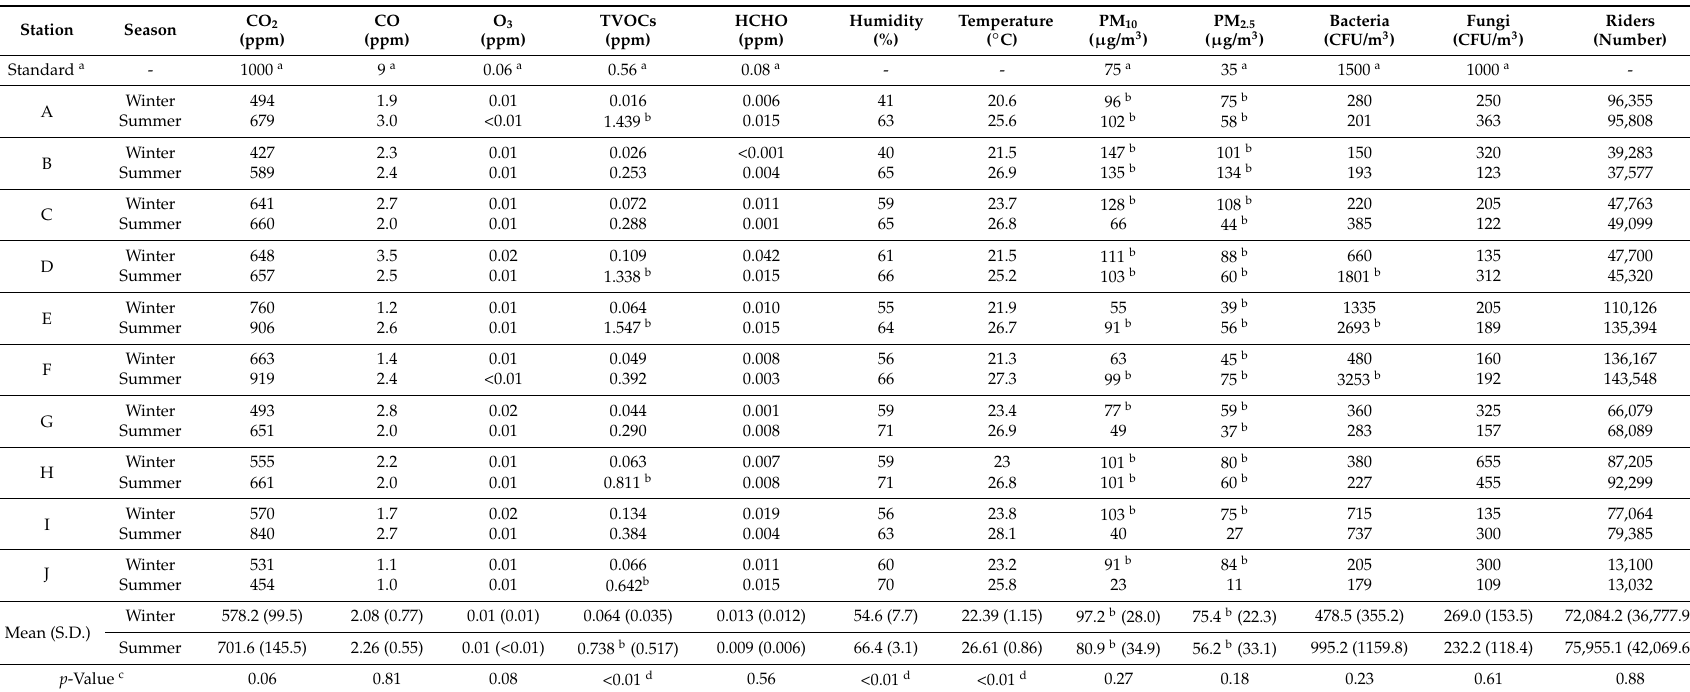
Table 3. Indoor air quality of the platforms of ten stations with top ridership in Taipei Rapid Transit system in